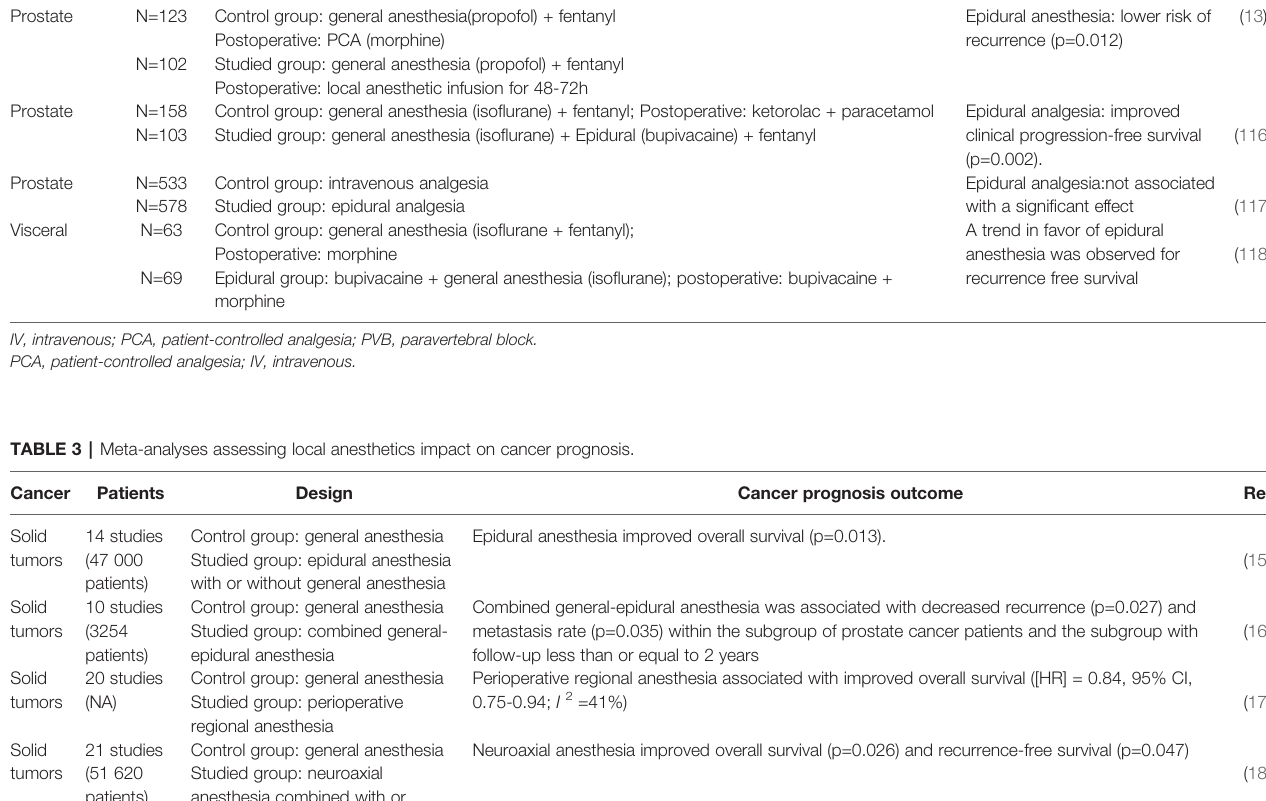
Patients Design Cancer prognosis outcome